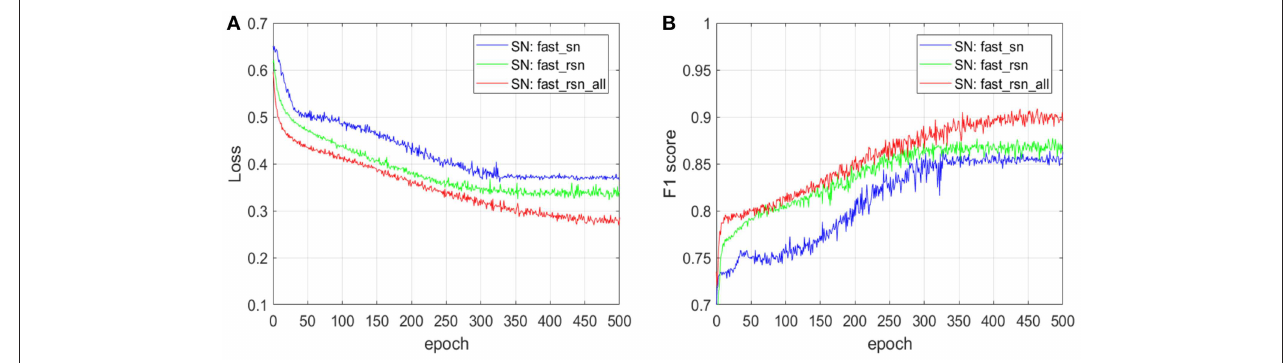
FIGURE 11 | The impact of fast_rsn and fast_rsn_all on the prediction accuracy of an ML pipeline. (A) Impact on cross-entropy loss. (B) Impact on F1